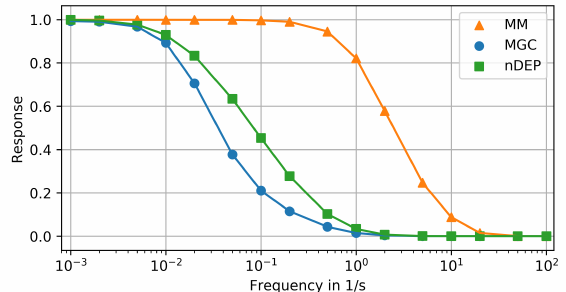
Figure 6. Frequency amplitude response diagram of compared devices: (1) MM (orange triangles), (2) MGC (blue dots), (3) nDEP (green squares).